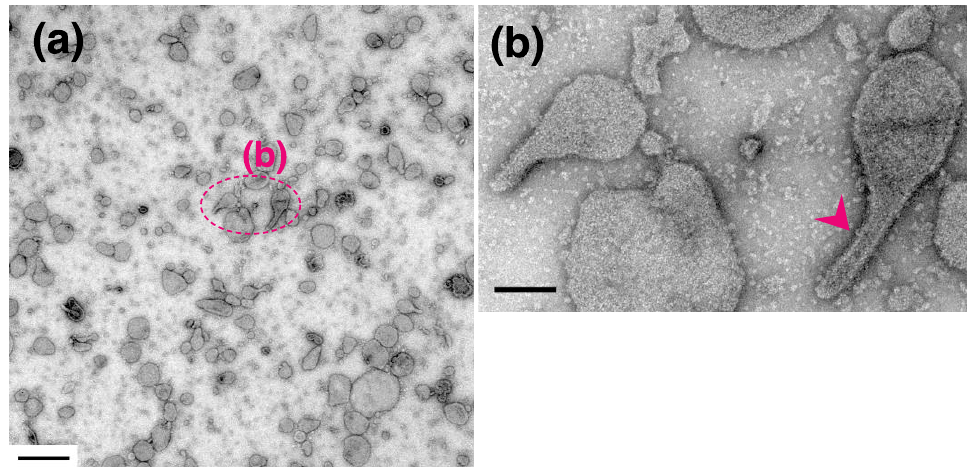
Figure 8. SR vesicles at 2.0 µM Ca 2+ in the presence of ATP at 0 °C. ( a ) Low magnification image of the vesicles. ( b ) Higher magnification of the annotated area. The tightly elongated vesicles (arrowhead) did not include a crystalline array. Scale bar in ( a ): 0.5 µm. Scale bar in ( b ): 100 nm.